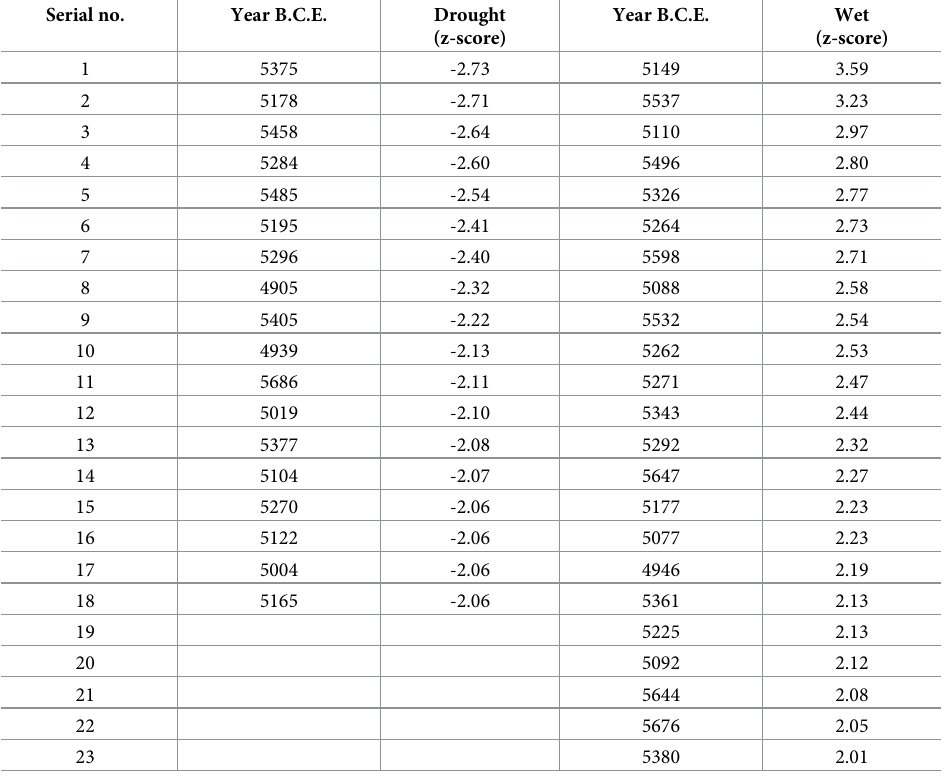
Table 1. Severe ( < -2 / > +2 z-scores) droughts and wet periods in southern Germany as reconstructed from tree rings. Serial no. Year